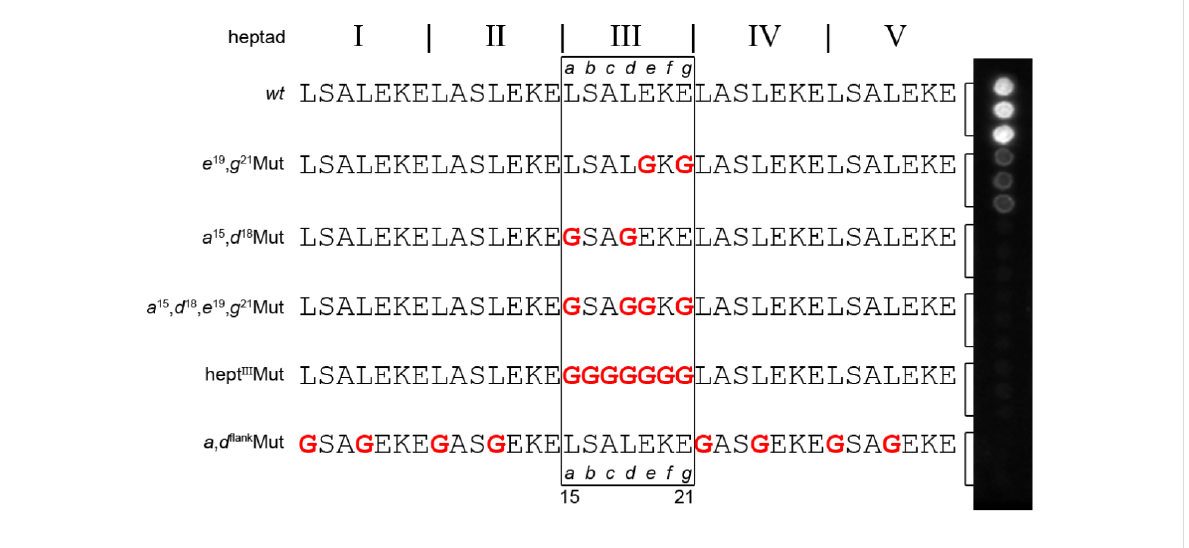
Figure 3: Glycine scanning of Acid-pp sequences. The substituted glycines are highlighted in red. Each sequence is followed by its corresponding spot (three replicas each). White spots indicate interactions between cellulose membrane-bound variants of Acid-pp and the TAMRA-labeled chimera.